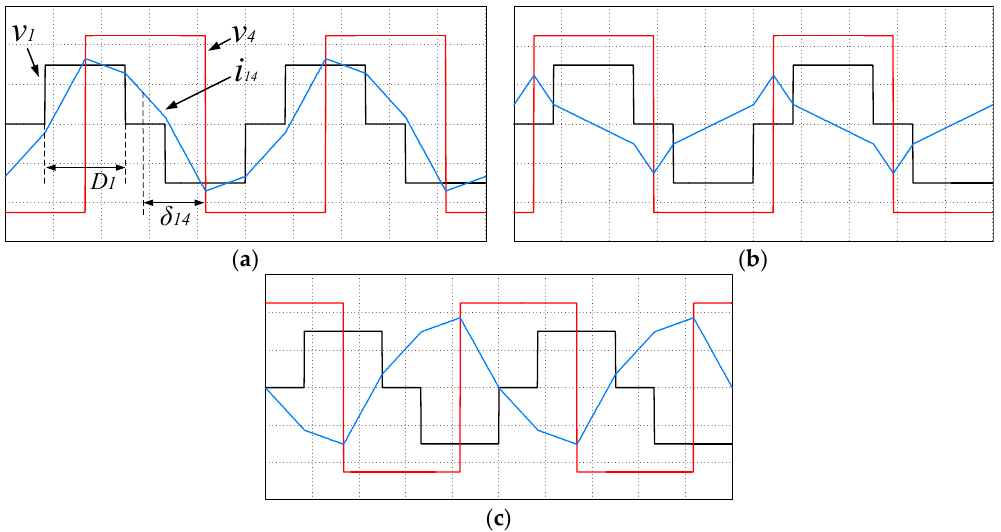
Figure 3. The waveforms of voltage and current of port one and four in the transformer winding for three cases wherein ( a ) v 1 is lagging v 4 , ( b ) v 1 and v 2 are in phase and ( c ) v 1 is leading v 2 , where duty cycle of v 1 ( D 1 ) and phase shift angle are presented.